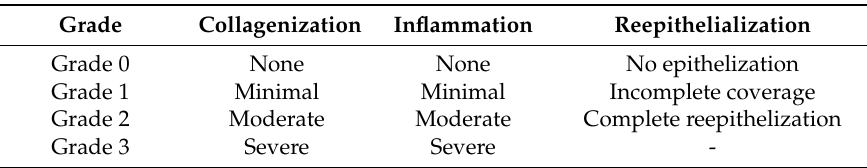
Figure 3. Histopathological images demonstrate the grade 0 ( A ), grade 1 ( B ), and grade 2 ( C ) of the reepithelization processes in the wound (H&E, × 100). Table 1. Histopathological grading system which was used to evaluate the wound-healing parameters collagenization, inflammation and